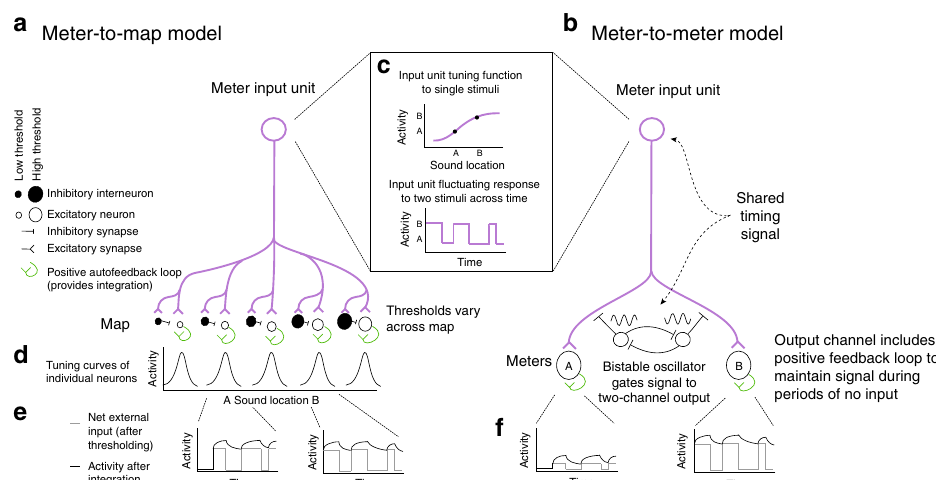
Fig. 7 Two possible mechanisms for de-multiplexing a fl uctuating signal. A clock signal that knows about coding transitions is not necessarily needed if signals are read out into a map ( a ), but is required if signals are retained in a meter or rate-coded format ( b ). Both models have an input signal that employs a meter code for sound location (purple, c top panel), and this signal is assumed to fl uctuate between two response levels when two sounds are present ( c bottom panel). In the meter-to-map model ( a ), the second stage consists of group of excitatory neurons (open circles) with varying thresholds, paired with inhibitory neurons ( fi lled circles) that have slightly higher thresholds. These neurons all receive input from the input meter signal. An individual excitatory neuron is activated when the input signal exceeds its own threshold and is lower than the threshold of the paired inhibitory interneuron, producing tuning curves like those shown in d . The net drive across time to two examples A and B is shown schematically as the thin gray line in the two inset graphs ( e ). These two neurons would turn on and off out of phase with each other based on their external inputs alone. Adding a positive autofeedback loop to each excitatory neuron in the map (green) provides integration of the activity of each neuron and permits the activity to be sustained across periods of time when there is no external drive (dark line). This model is derived from a portion of the Vector Subtraction model of 66 . In the meter- to-meter model ( b ), the input is forked to an A meter channel neuron and a B meter channel neuron. A bistable oscillator coupled to the same unknown clock (shared timing signal) that controls the input fl uctuations would be needed to appropriately route the output to these two units. The resulting output, in the absence of positive autofeedback, would also fl uctuate but between an off state and a level that corresponds to signaling the presence of sound A or B respectively ( f gray lines). Adding positive autofeedback would again allow bridging across the off states (dark